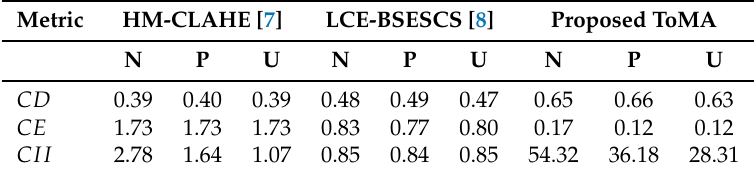
Table 3. Comparisons of the prior and proposed contrast enhancements. ToMA = texture-based morphological analysis; CD = Contrast Difference; CE = Contrast Enhancement; CII = Contrast Improvement